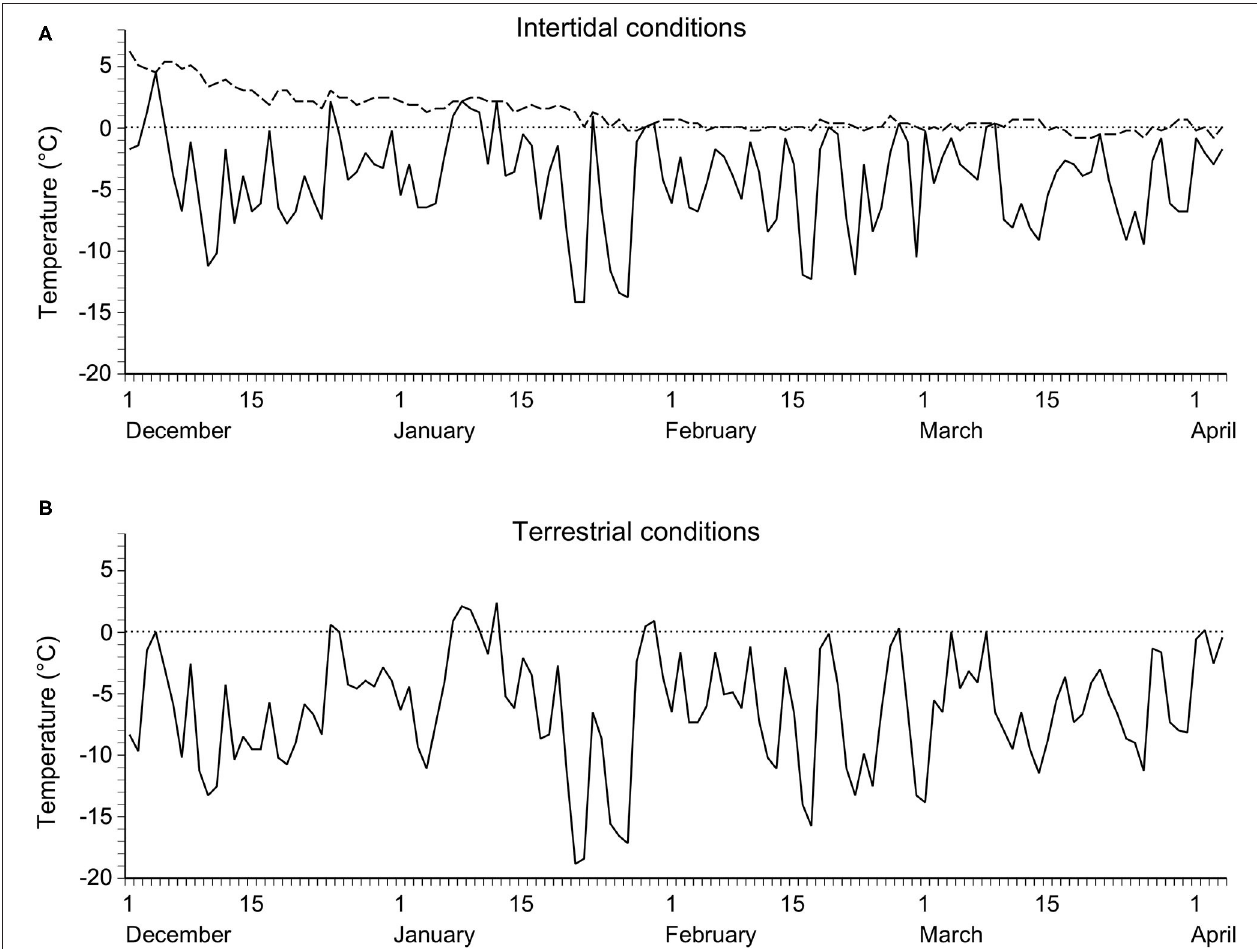
FIGURE 2 | (A) Daily minimum intertidal temperature (solid line) and daily sea surface temperature (dashed line) and (B) daily minimum temperature (means of two loggers) in a nearby terrestrial environment between 1 December 2007 and 4 April 2008 at Tor Bay Provincial Park, on the open Atlantic coast of Nova Scotia, Canada.